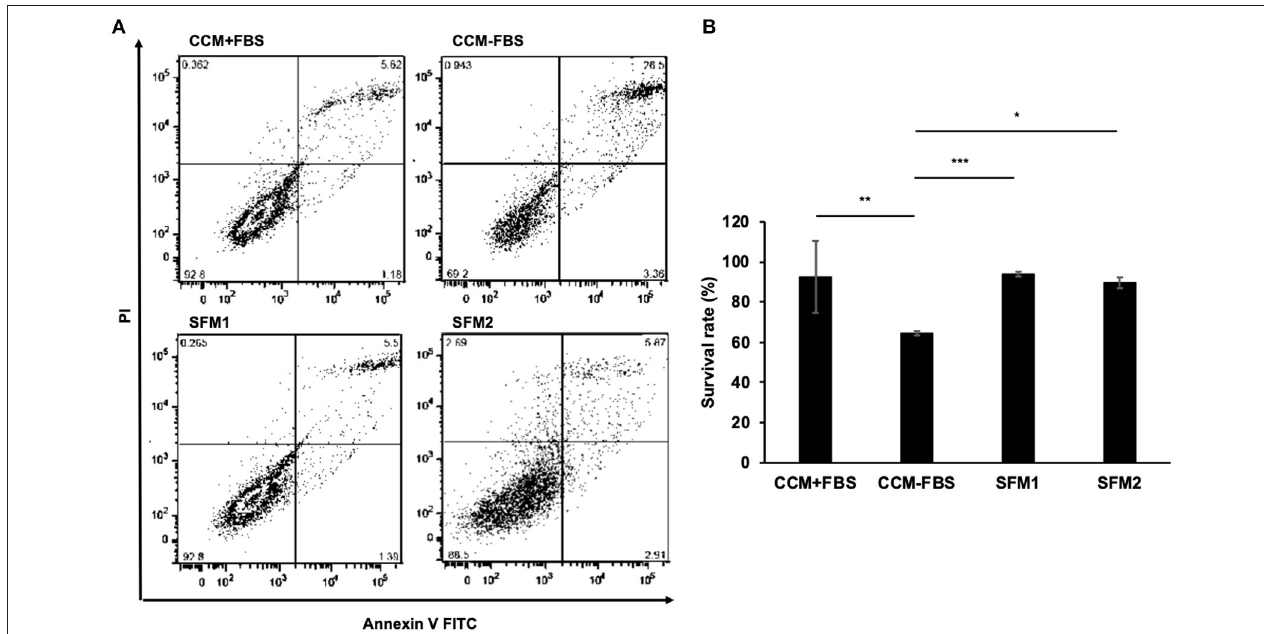
FIGURE 2 | Survival rates of canine MSCs. (A) Representative dot plots of Annexin V FITC-PI double staining with canine MSCs cultured in CCM + FBS, CCM–FBS, two kinds of SFM: SFM 1 and SFM 2. (B) Mean ± SD percentage of viable cells cultured in CCM + FBS, CCM–FBS, SFM 1 and SFM 2. Survival rates were calculated from the number of viable cells divided by total cell counts. There was no significant difference between the survival rate of MSCs in CCM + FBS and SFM (SFM 1 and SFM 2). The proportion of surviving cells in CCM + FBS, SFM 1 and SFM 2 was significantly higher than that of CCM–FBS (* p < 0.05, ** p < 0.01, *** p <